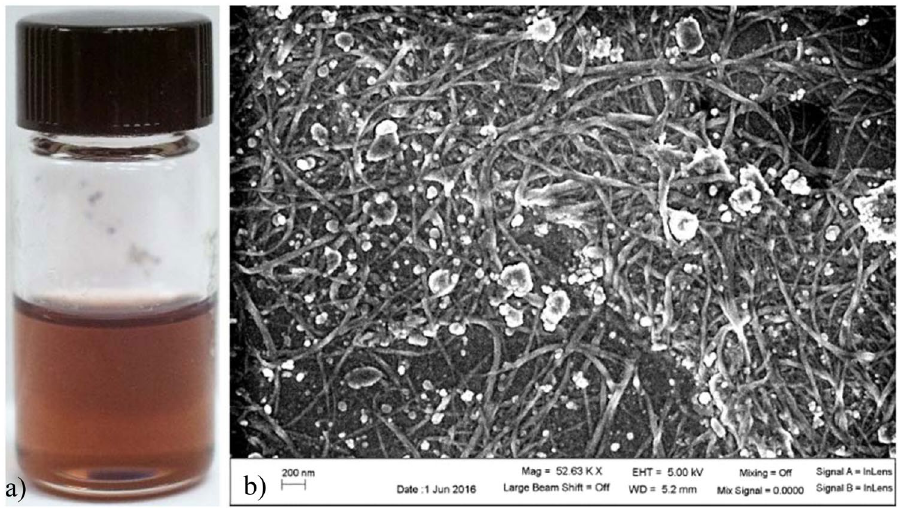
Figure 2. ( a ) A vial of SWCNT ink with a 20% CNT concentration by weight. ( b ) SEM image of a CNT film post-annealing. While there is residual from the solvent, conductivity is not